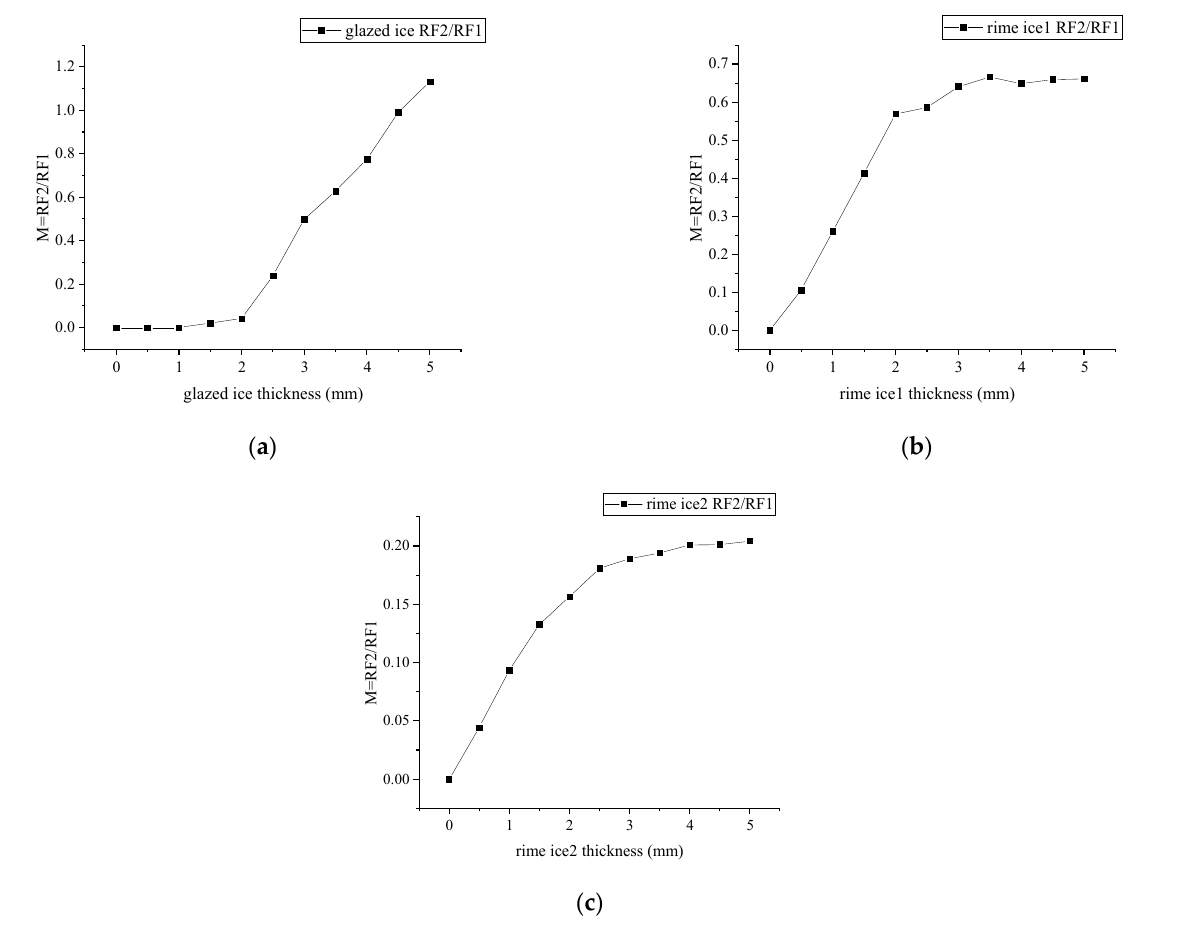
Figure 6. Light intensity modulation functions for different icing types: ( a ) M at glazed ice; ( b ) M at rime ice 1; ( c ) M at rime ice 2.